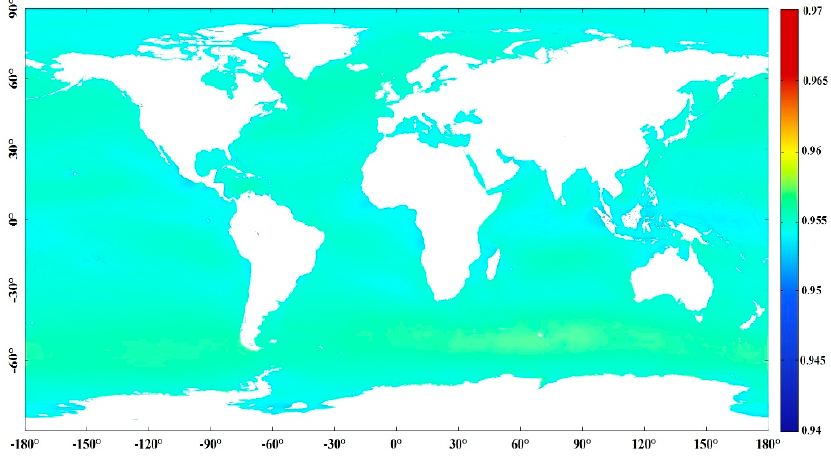
Figure 11. Mean global sea surface hemispherical BBE values at 12:30 (UTC time) from 2003 to 2005.